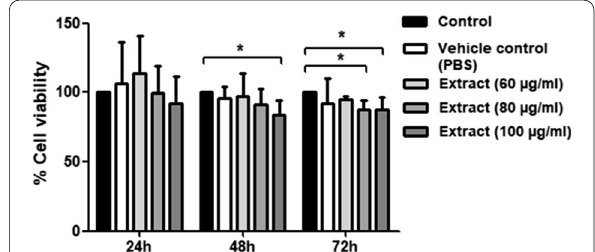
Fig. 2 F. hepatica extract decreased the FLS viability. F. hepatica extract was tested at different concentration (0, 60, 80, 100 µg/mL) and timepoints (24, 48 and 72 h) in FLS cultures. Cell viability was evaluated by MTT test. A decrease in cell viability was observed at concentration of 100 µg/mL after 48 h and at concentrations of 80 µg/mL and 100 µg/mL after 72 h, when compared with the control group without treatment. * p < 0.05; ANOVA two-way. (n Data were normalized as percent of control at each time point and is